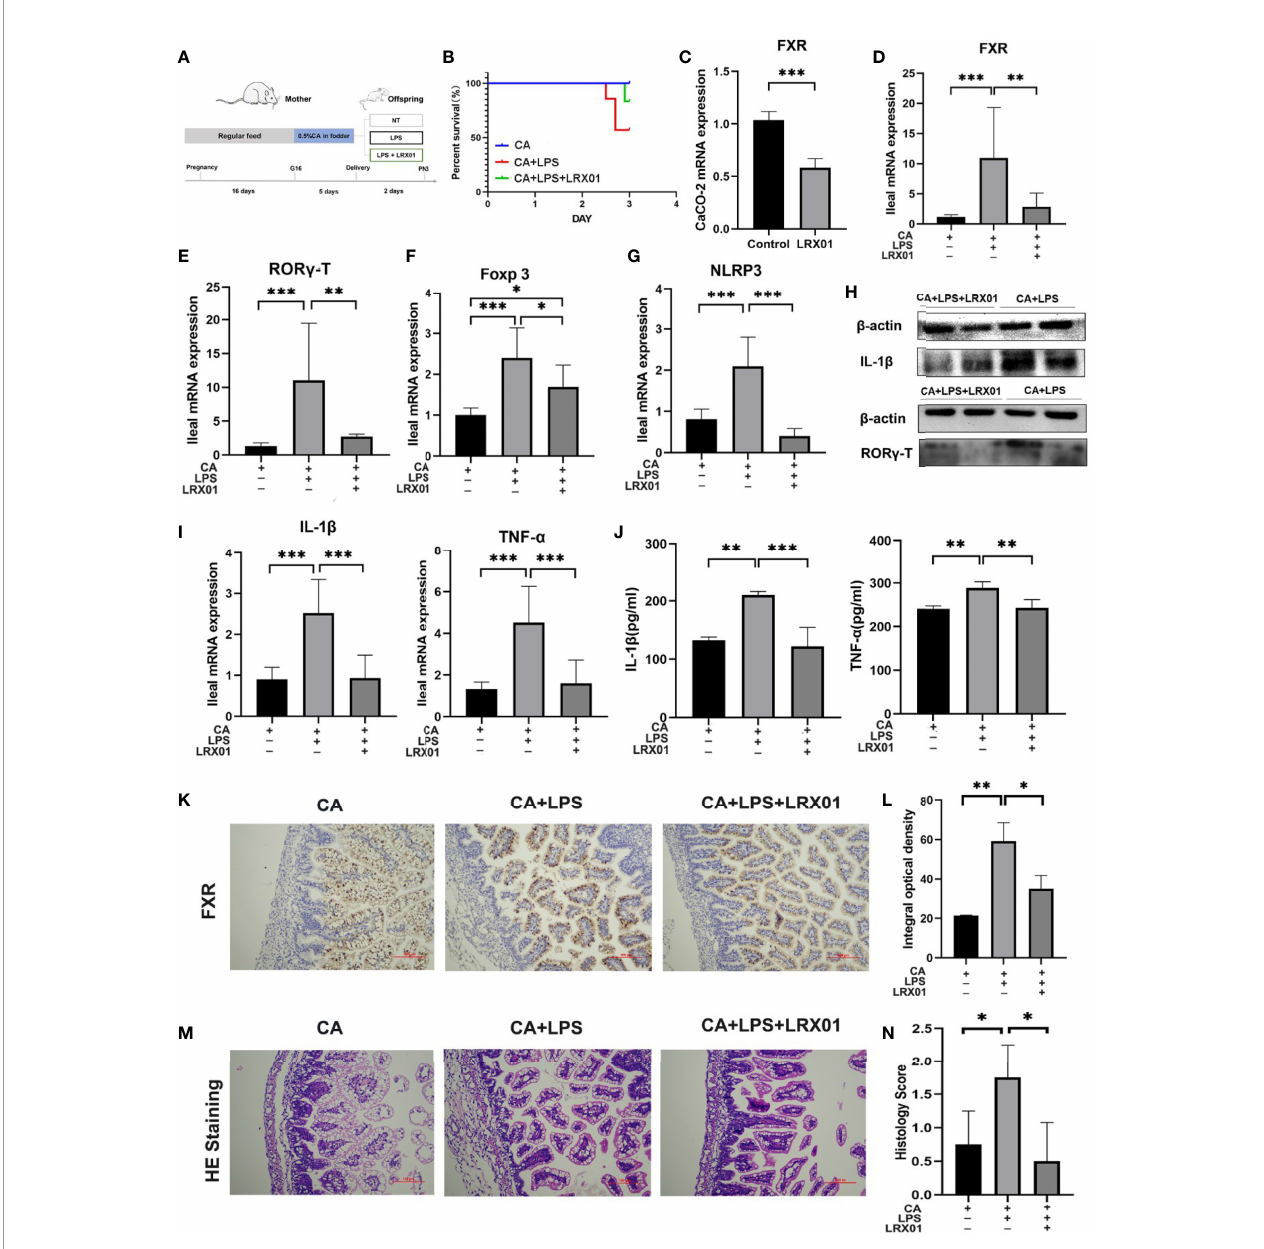
FIGURE 7 | Bacteria-mediated inhibition of FXR reduced susceptibility to LPS exposure in the offspring from CA-fed mothers. (A) Flow diagram of the experimental procedure. (B) Survival analyses of three groups. (C) FXR mRNA expression in CaCO-2 experiment. (D – G) Ileal mRNA expression of FXR, ROR g -T, Foxp3, and NLRP3 in rats. (H) Western blot analysis of IL-1 b and ROR g -T in ileum. (I) Ileal mRNA expression of IL-1 b and TNF- a . (J) IL-1 b and TNF- a serum levels in three groups (K) Immunohistochemical staining for FXR (brown) in ileum tissue section. (L) Comparison of integral optical density among groups. (M) Microscopic observation of the ileum tissue with hematoxylin and eosin (HE) staining. (N) Comparison of histology scores among groups. Scale bar, 100 mm. Magni fi cation, ×200. *p < 0.05, **p < 0.01, ***p<0.001. N